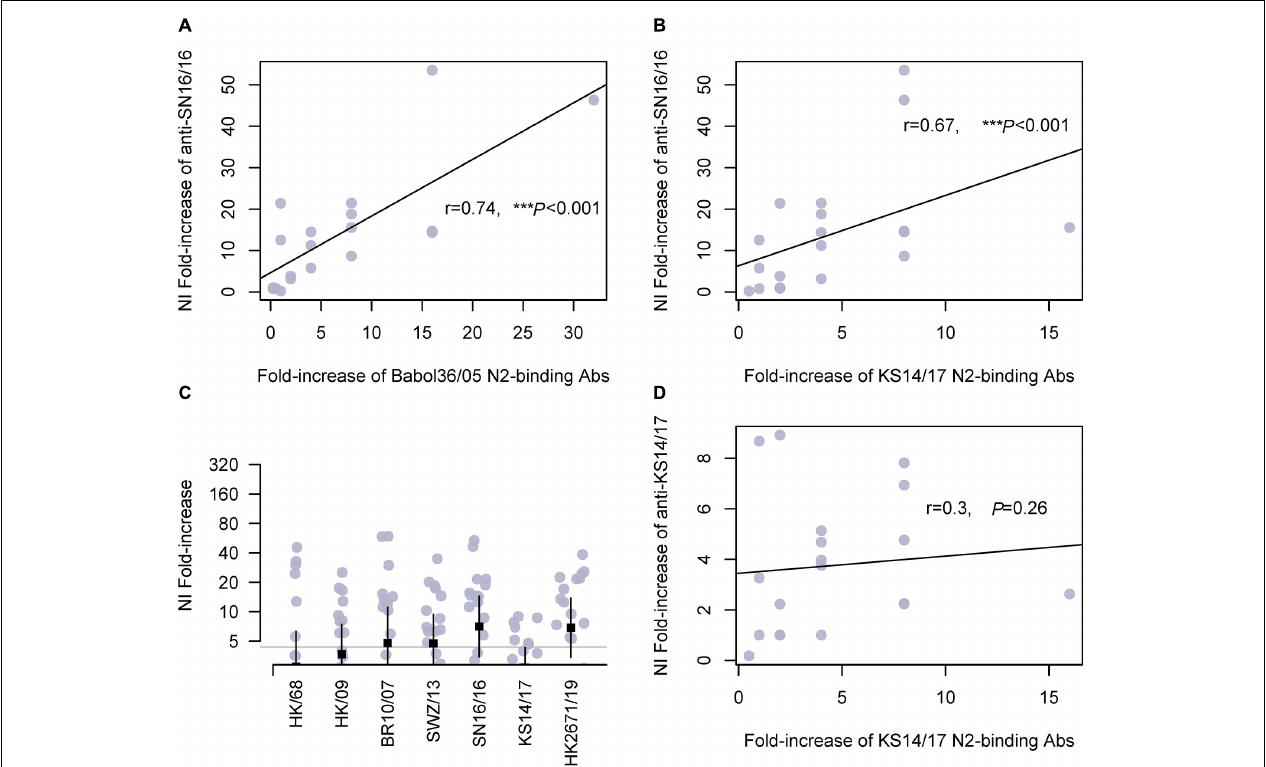
FIGURE 3 | Cross-reactivity of serum N2-binding Abs in children and correlations with NI Abs. (A) Correlation of fold increase between anti-SN16/16 NI Ab and N2-binding Ab of A/Babol/36/05(H3N2, Babol36/05). (B) Correlation of fold increase between anti-SN16/16 NI Ab and N2-binding Ab of A/Kansas/14/2017(H3N2, KS14/17). (C) Fold increase of NI Abs against RG H6N2 viruses bearing N2 of A/Hongkong/1968(H3N2, HK/68), A/Hongkong/33982/2009(H9N2, HK/09), 2009H9N2(HK/09), A/Brisbane/10/2007(H3N2, Br10/07), A/Switzerland/9715293/2013(H3N2, SWZ/13), SN16/16, A/KS14/17, and Hongkong/2671/2019(H3N2, HK2671/19), respectively. (D) Correlations between anti-KS14/17 NI and KS14/17-binding Abs in children. The gray line (C) is 4, and the positive conversion is fold increase ≥ 4. The line in (A,B,D) is the regression line. The mean ± 95% CI is shown. The r- and p -values are indicated. *** <